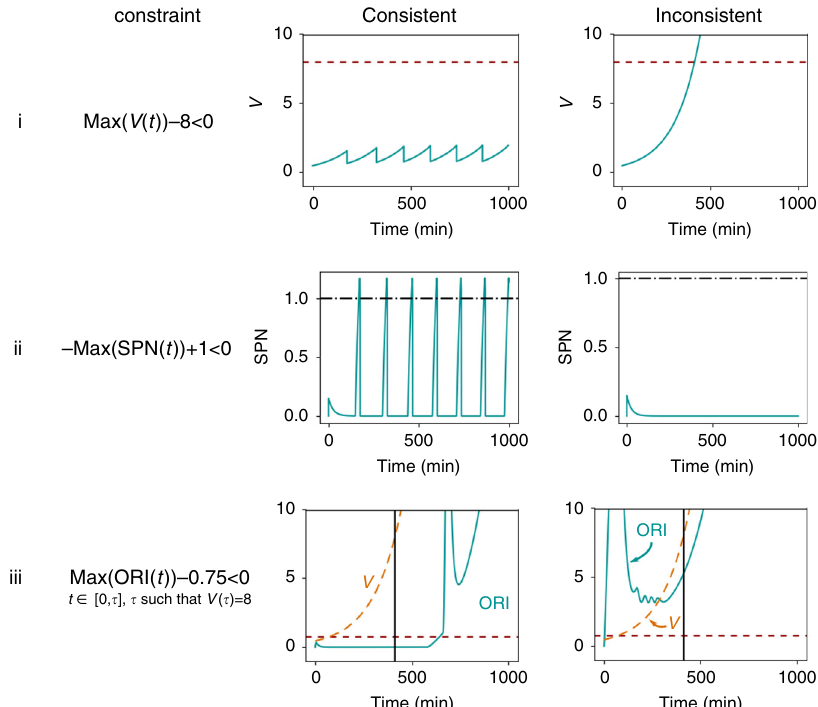
Fig. 3 Example constraints used in parameterizing the yeast cell cycle model. The constraints are based on known properties of particular cell phenotypes: Row (i) In a viable cell, the cell must divide before the normalized volume V reaches 8. Row (ii) In a viable cell, the assembly of the mitotic spindle SPN must fi nish (reach 1). Row (iii) In an inviable cell in G1 arrest, origin activation ORI does not fi nish (fails to reach 1). Each property was converted to an inequality constraint on one of the outputs of the model. Simulations of cells corresponding to the particular phenotype should be consistent with the constraint (left panels). Simulations of cells corresponding to some other phenotype may not be consistent with the constraint (right panels). Red broken lines indicate that the trace must never exceed the indicated value, and black dash-dot lines indicate the trace must exceed the value at some point. In row iii, the constraint is only enforced to the left of the vertical line, which is located at time τ such that V ( τ ) =